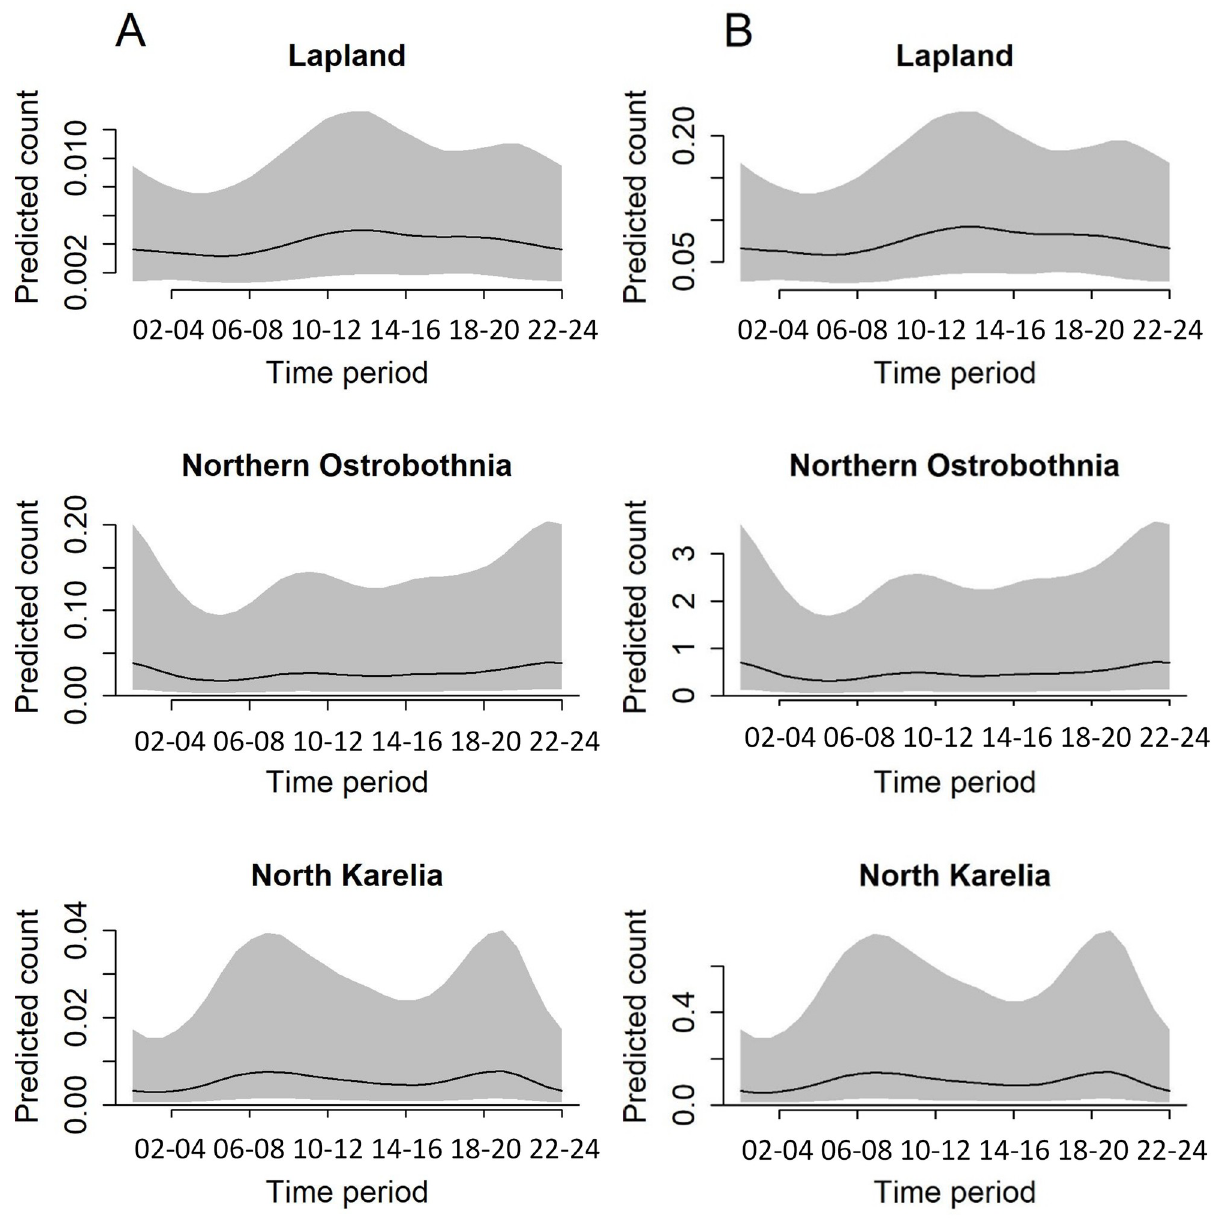
Fig 3. Diel variation in taiga bean goose count. Model predicted count (per unit effort) of taiga bean geese (mean with 95% prediction interval) with time period for the years a) 2018 and b) 2019. 24th of June and 14th of July. During that period most of the geese were observed during the night and the hours of early morning, with a decline in activity between 12:00 and 20:00. Also in Northern Ostrobothnia, the peak started at the same time, but lasted longer (until 29th of July). In addition, the geese were most active over two long periods throughout the day: in 20:00–06:00 and in 08:00–16:00. In contrast, in the southernmost region, North Karelia, the largest counts occurred much later, between the 19th of July and the 13th of August, which may indicate more activities related to migration rather than moulting. In addition, the diel